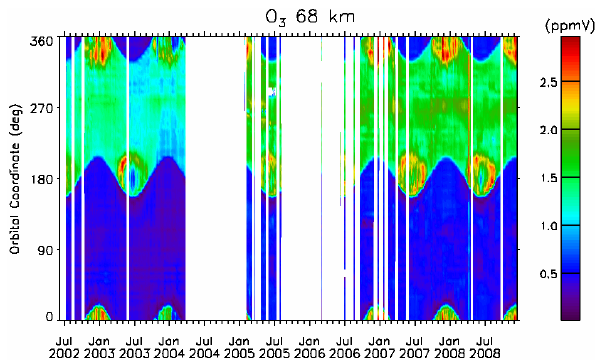
Fig. 12. 5-days means of NO 2 VMR (ppmv) at 47km plotted as a function of the OC and the acquisition